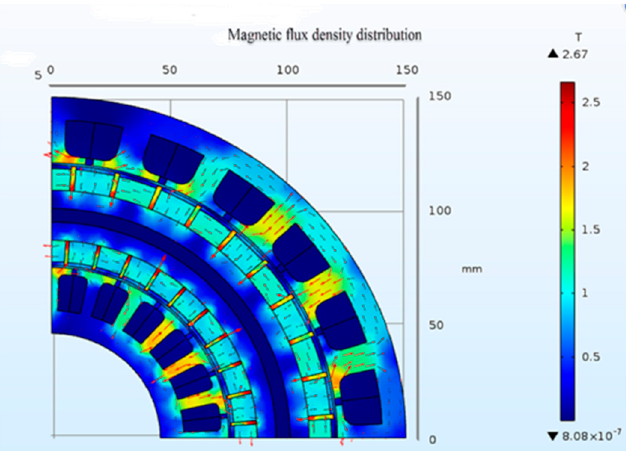
Figure 4. Magnetic flux density distribution. Energies 2020 , 13 , x FOR PEER REVIEW